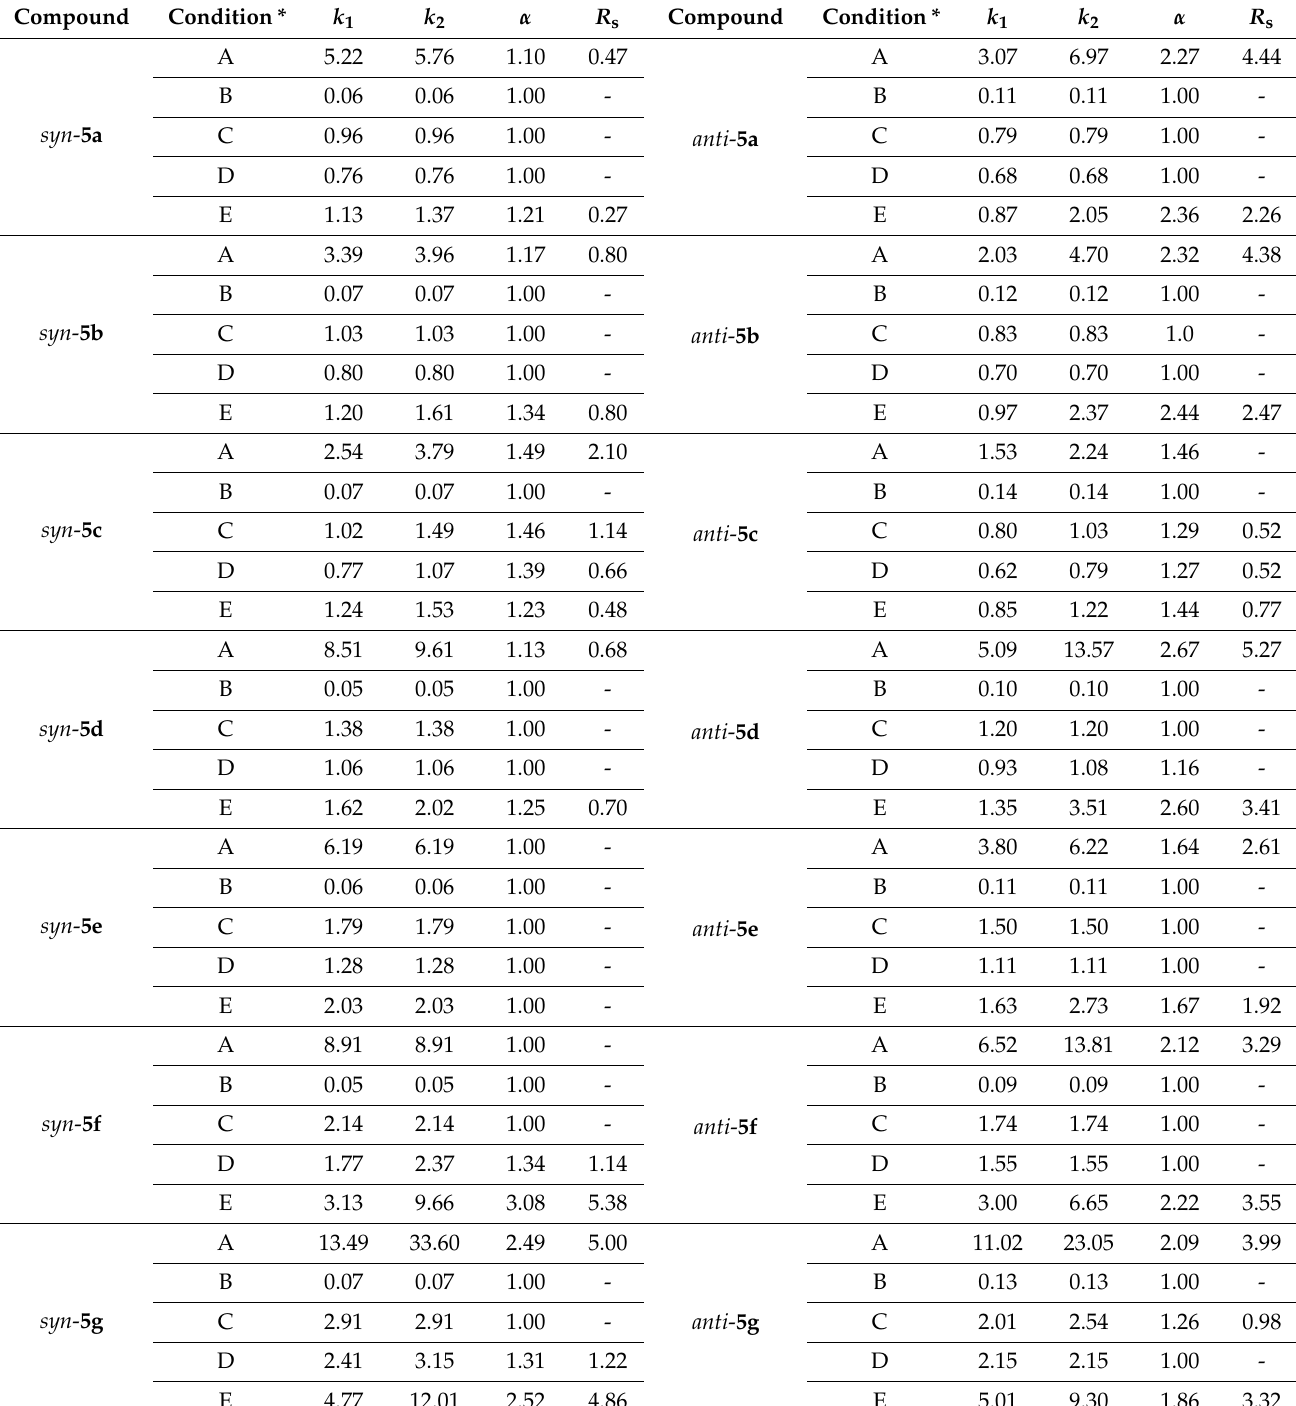
Table 3. Chromatographic parameters for the enantioselective separations of racemic syn -and anti - 3,5-disubstituted hydantoins on